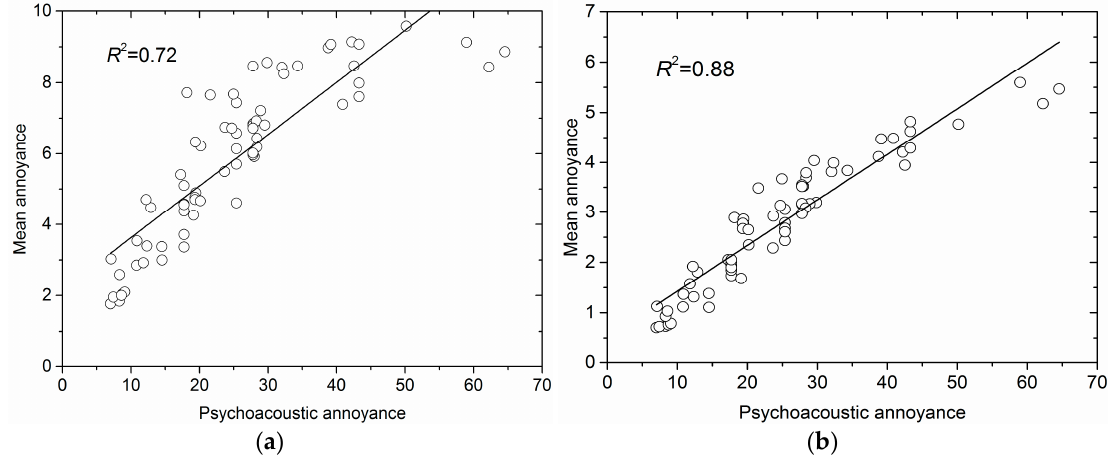
Figure 5. Linear fitting between PA and MA of all noise samples in sample sets 1–6. ( a ) before calibration; ( b ) after calibration.